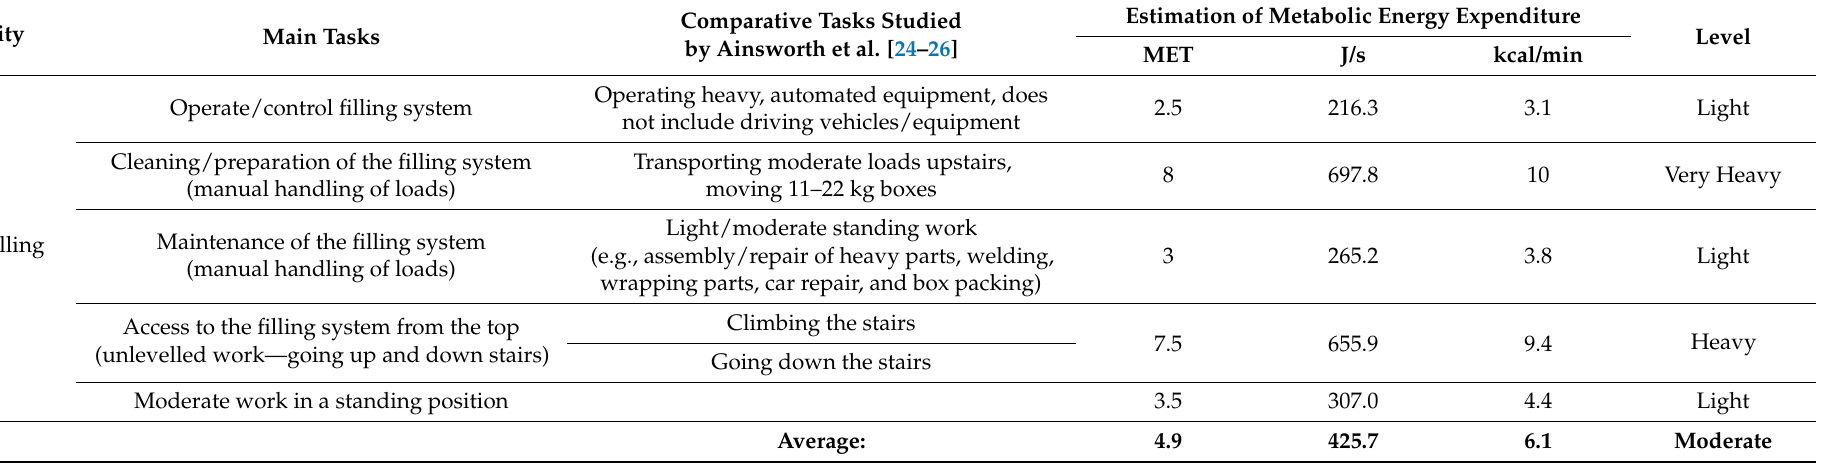
Table 1. Illustrative example of the comparison of tasks previously studied in various research works to estimate the metabolic energy expended during the bottling filling